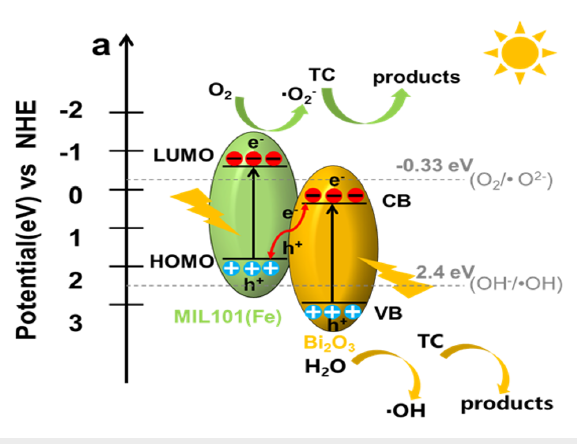
Figure 10: Z-Scheme charge-transfer mechanism of a BOM-20 heterojunction.